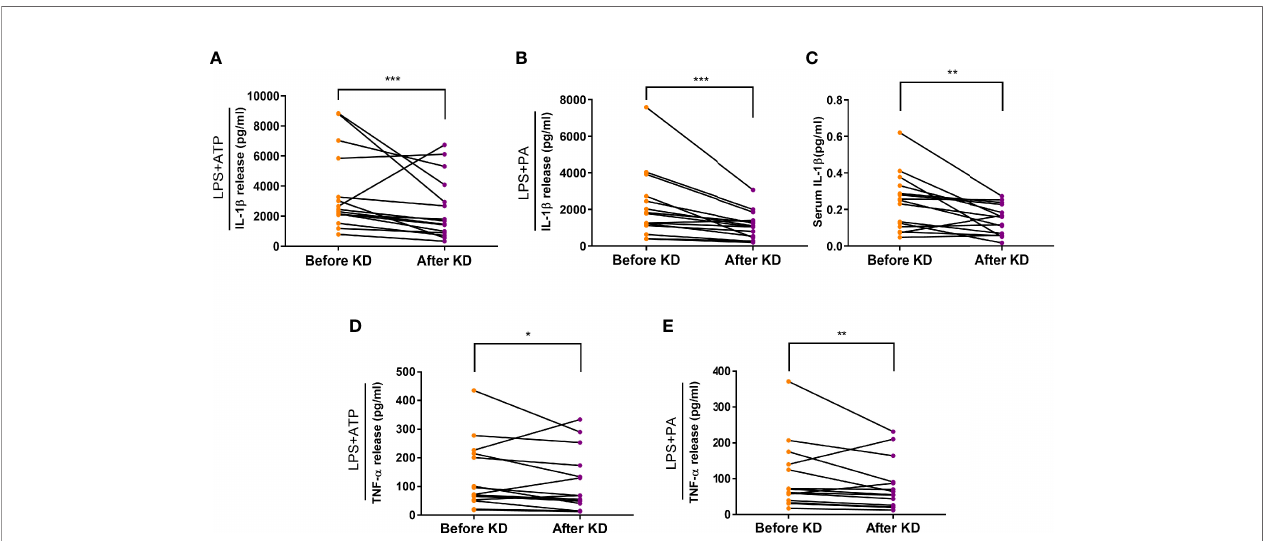
FIGURE 3 | Effects of isocaloric ketogenic diet on secretion of IL-1 b and TNF- a from macrophages. Secretion of IL-1 b : ELISA assay measurement of IL-1 b secretion from macrophages exposed to 2 mM ATP (A) or 0.2 mM palmitate (B) with 0.1 µg/ml LPS priming; changes in serum IL-1 b levels (C) ; TNF- a secretion from macrophages exposed to ATP (D) or palmitate (E) . Experiments with macrophage were repeated two or three times per sample; graphs are drawn using mean values of those results per sample, whereas statistical signi fi cance is derived from raw data. Two-sided paired t-test or Wilcoxon signed rank test; * P < 0.05, ** P < 0.01, and *** P < 0.001 vs. baseline. PA, palmitate; ATP, adenosine triphosphate; LPS, lipopolysaccharide; IL-1 b , interleukin-1 b ; KD, ketogenic diet; TNF- a , tumor necrosis factor- a